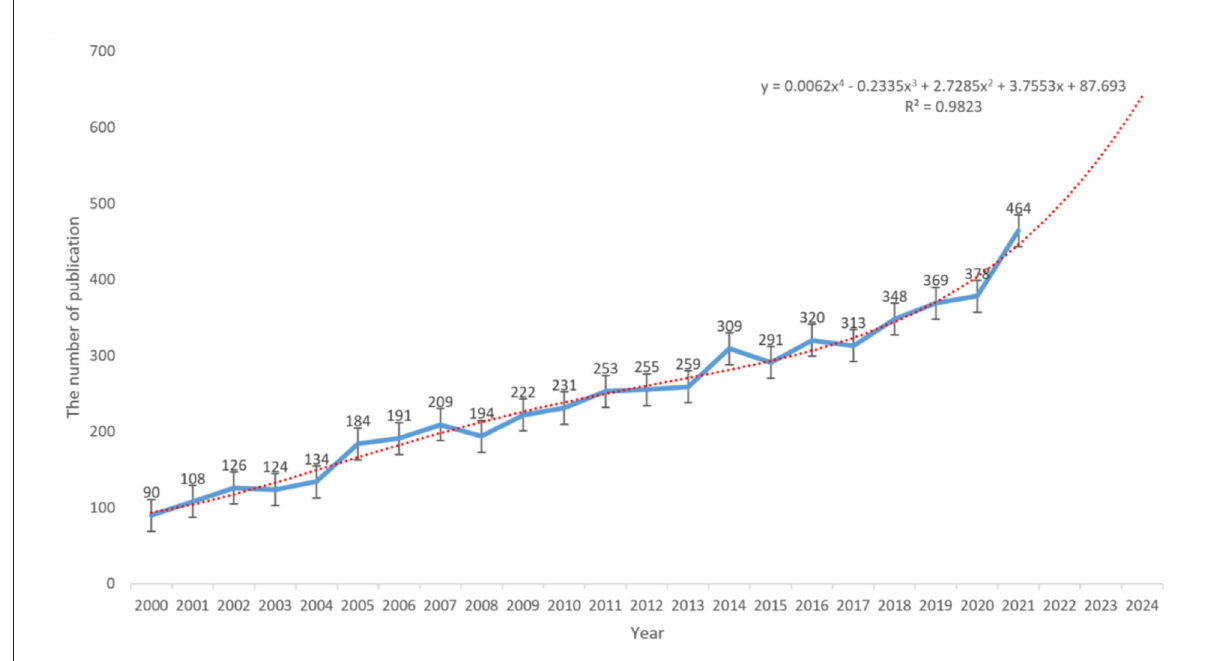
FIGURE1 Polynomial curve fitting of publication growth in the field of radiotherapy for rectal